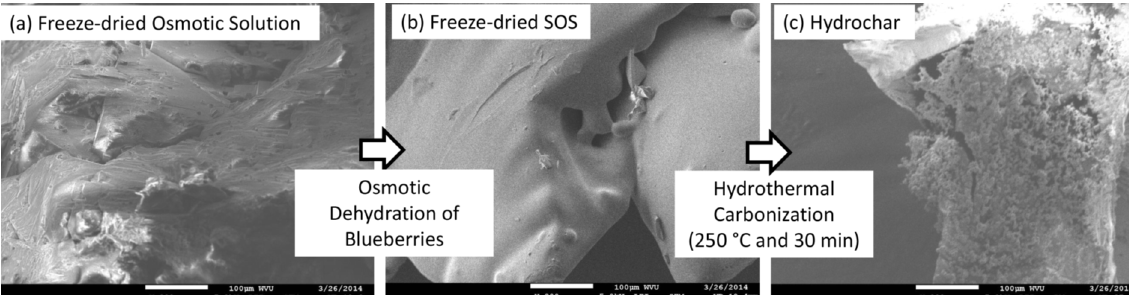
Figure 2. SEM pictures of ( a ) freeze-dried osmotic sugar solution ( b ) freeze-dried SOS and ( c ) hydrochar made from SOS through hydrothermal carbonization at 250 °C with 30 min of reaction